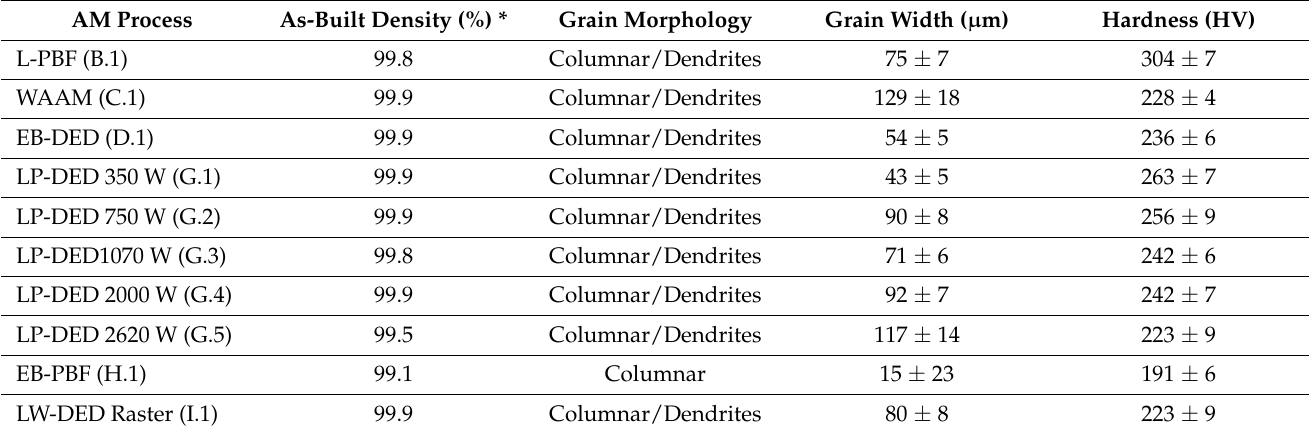
Table 2. Summary of AM process microstructures and related properties of as-built